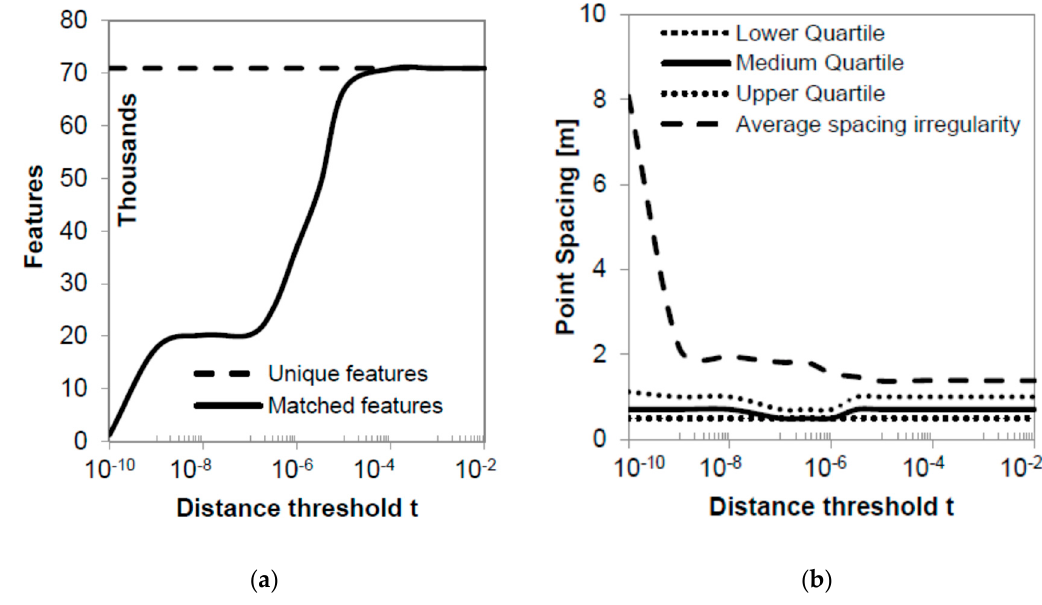
Figure 9. ( a ) Number of resulting unique and tentative feature matches and ( b ) homologous feature spacing statistics for different values of RANSAC distance threshold 𝒕 on a logarithmic scale.